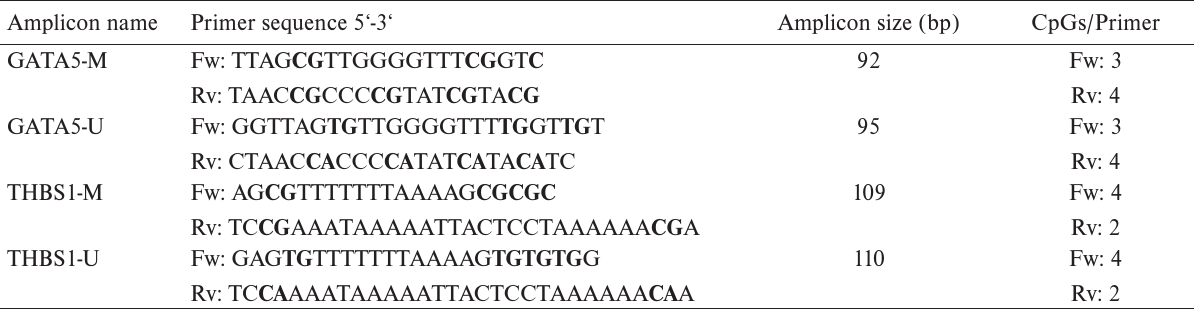
Table 1. MSP primers and amplicon information.